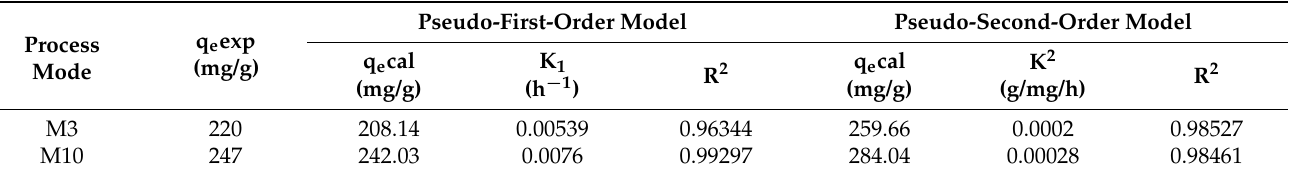
Table 6. Fitting parameter values of the two kinetic models.